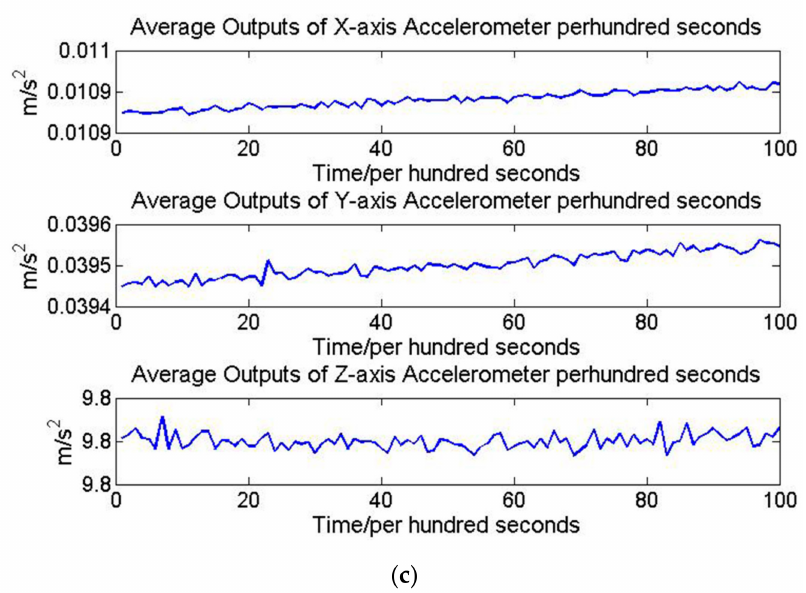
Figure 5. ( a ) Environment temperature variation, ( b ) accelerometers temperature variation, and ( c ) the average outputs of accelerometers per hundred seconds.